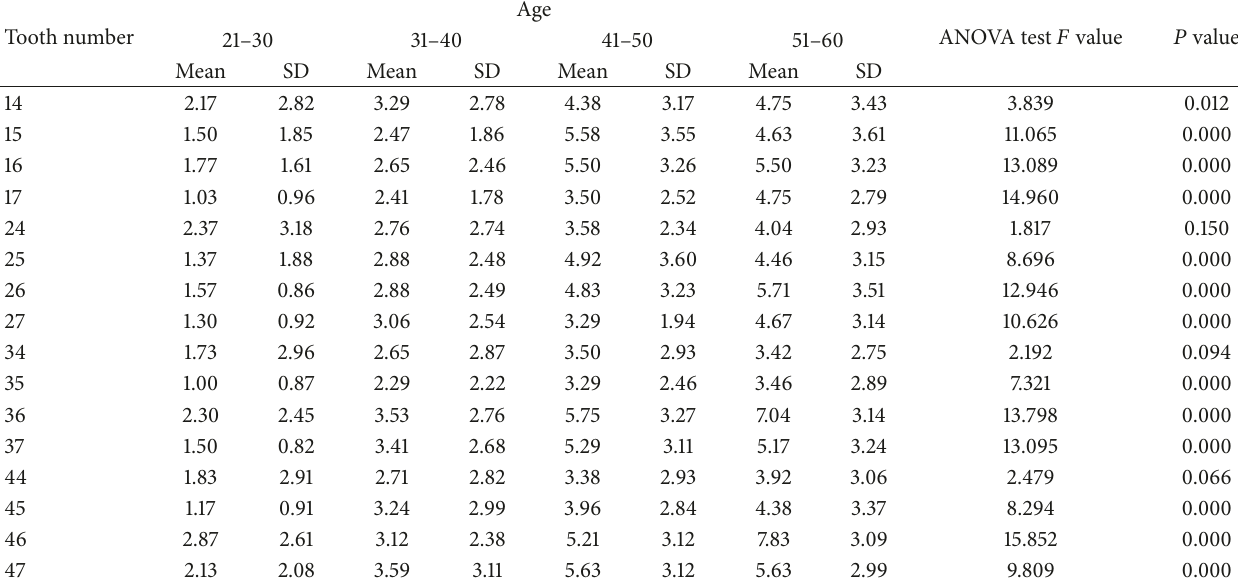
Table 4: Comparison of mean wear scores of each tooth across different age groups using ANOVA. Tooth number